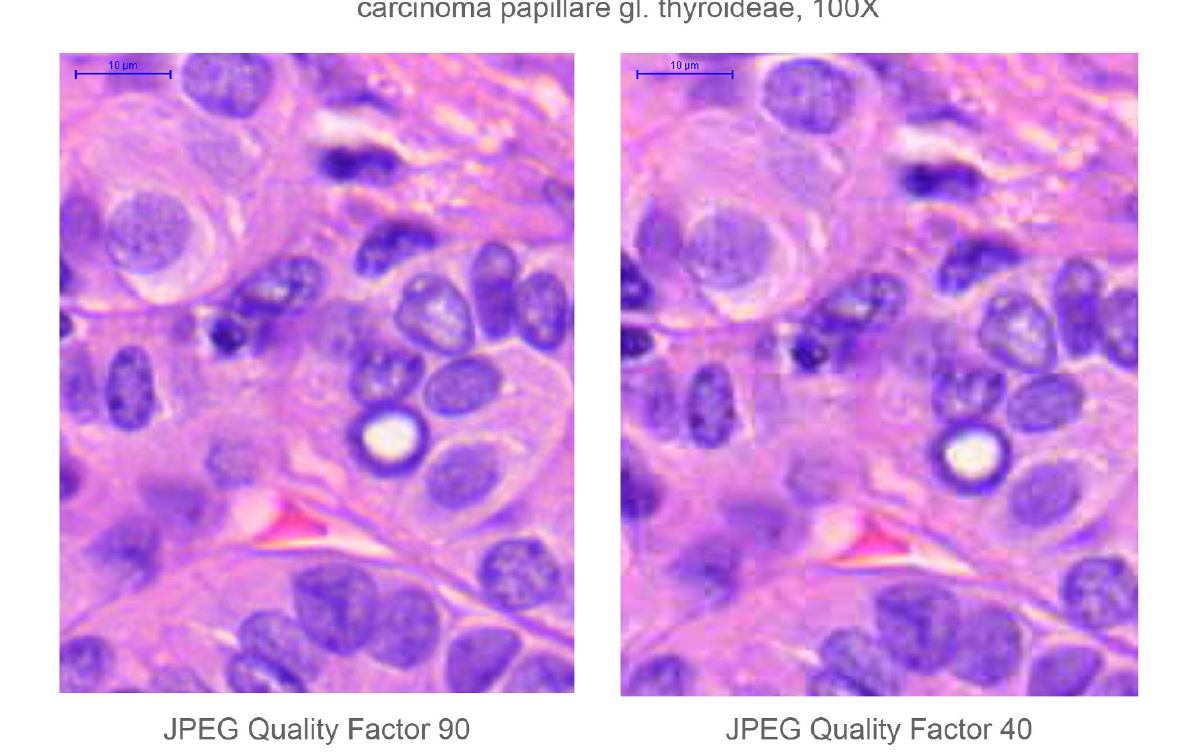
Figure 1 Difference between the resolution of the original (JPEG Quality factor compression 90) and the compressed (JPEG Quality factor compression 40) digital slide, depicting the same region of a papillary thyroid cancer. (HE-stain, 100× magnification.) The pixelation is clearly visible on the right image, after compressing the digital